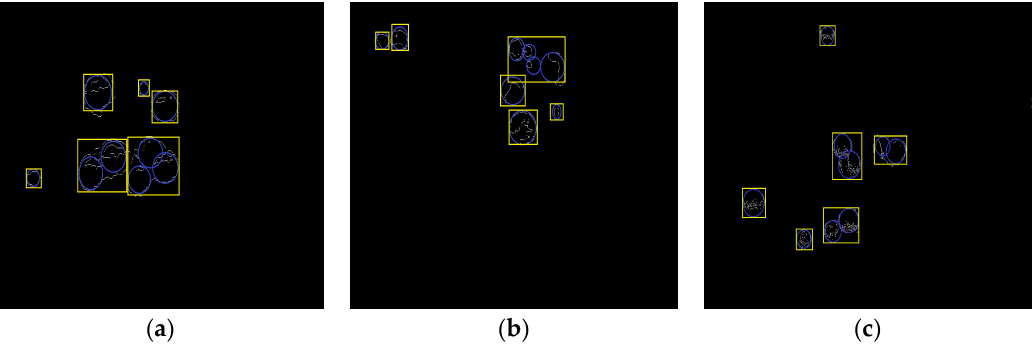
Figure 13. The extraction results of mature litchi fruits based on combining the four different classifiers under different illumination conditions. ( a ) The extraction results obtained under front-lighting conditions; ( b ) The extraction results obtained under back-lighting conditions; ( c ) The extraction results obtained under cloudy day conditions.